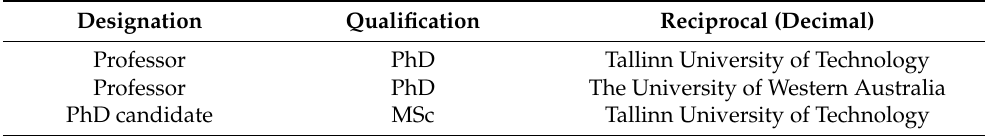
Table 3. Experts involved in evaluating the criteria using the AHP